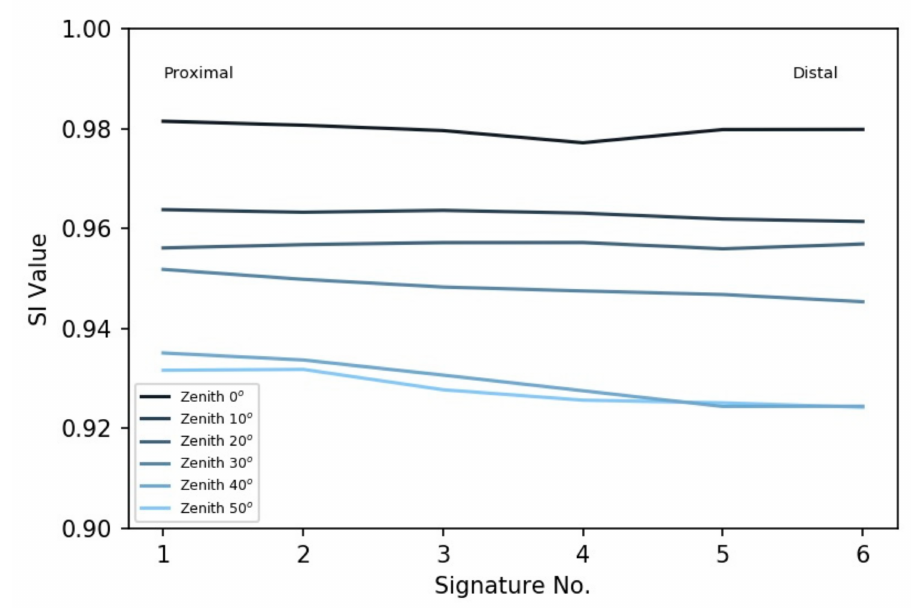
Figure 9. SI values for each shadow signature at each zenith angle. SI values decrease with increasing zenith angle. The di ff erence in SI value between proximal (dark) shadow to distal (light) shadow increases with increasing zenith angle. As zenith angle increases, proximal areas of shadow have higher SI values than distal areas of shadow.